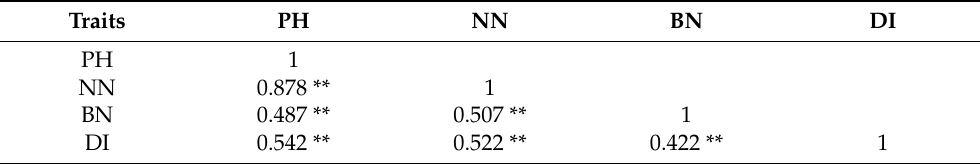
Figure 2. Frequency distribution of plant architecture-related traits in soybean mini core collection. ( a – d ) Frequency distribution of PH, NN, BN, and DI. Table 2. Correlation analysis of plant architecture-related traits in soybean.